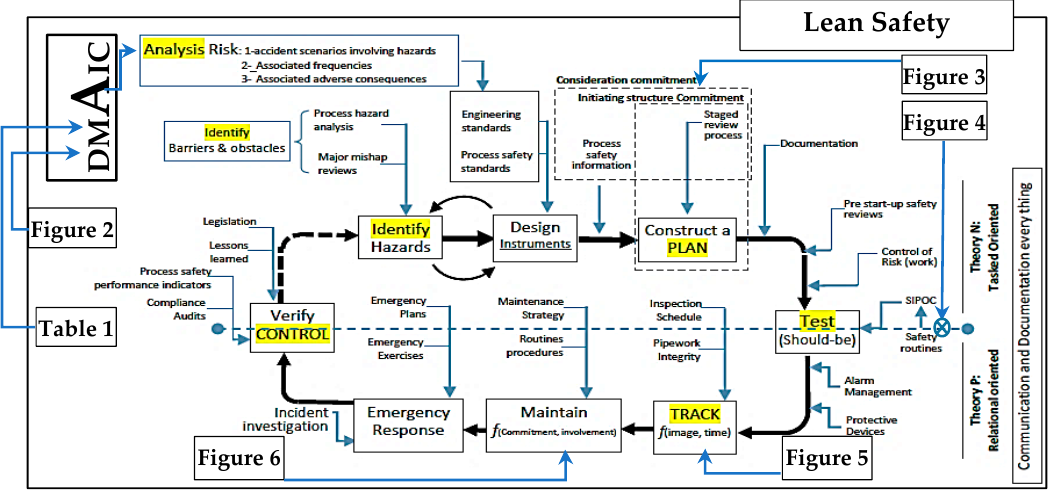
Figure 1. The LSPL Measurement and Analysis stages. Table 3. Lean Safety Performance Level (LSPL) and their implementation tools’ definition.